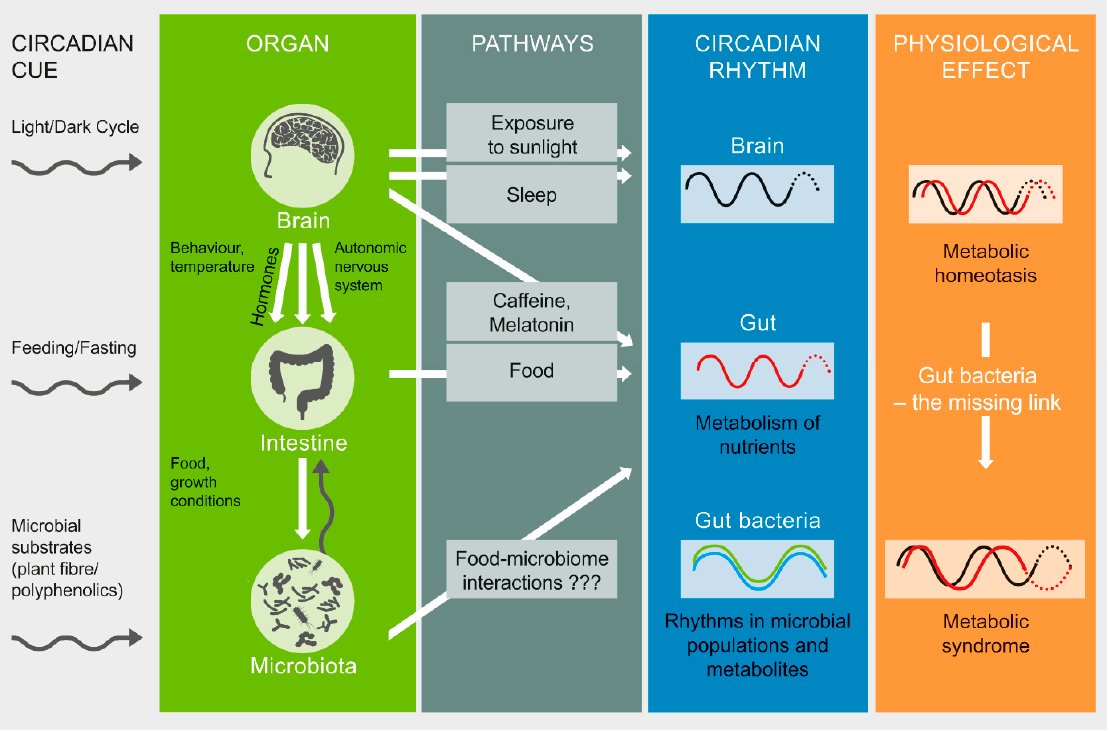
Figure 1. Circadian rhythm, gut microbiota, and metabolism. The light/dark cycle is the Zeitgeber for the central clock in the brain, while signals from the brain entrain peripheral clocks, e.g., in the intestine. Intestinal bacteria also show diurnal fluctuations in terms of their abundance and functions. Host controlled behaviors such as sleep, diet (food composition, timing of eating a meal), light exposure, and stimulants (e.g., caffeine) may potentially affect intestinal rhythms of metabolism. New evidence indicates that gut microbiota influences circadian rhythms, with consequent impact on the metabolic homeostasis of the host (Figure adapted from [1]).